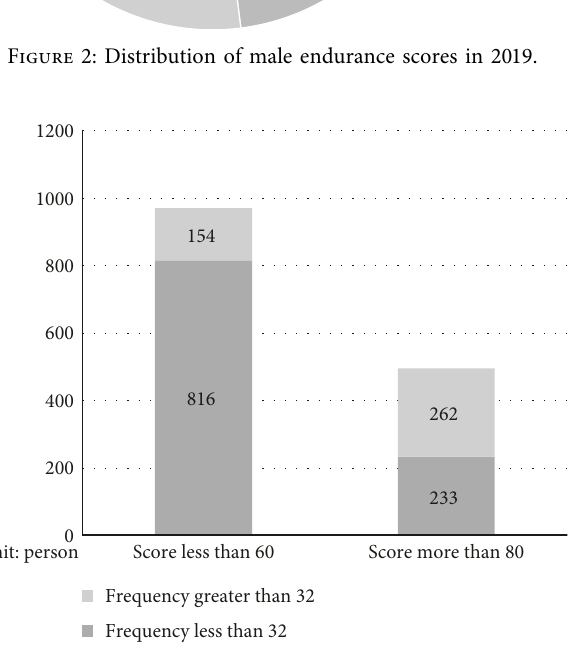
Figure 3: Boys’ endurance scores and long-distance running frequency in the second semester of 2019.